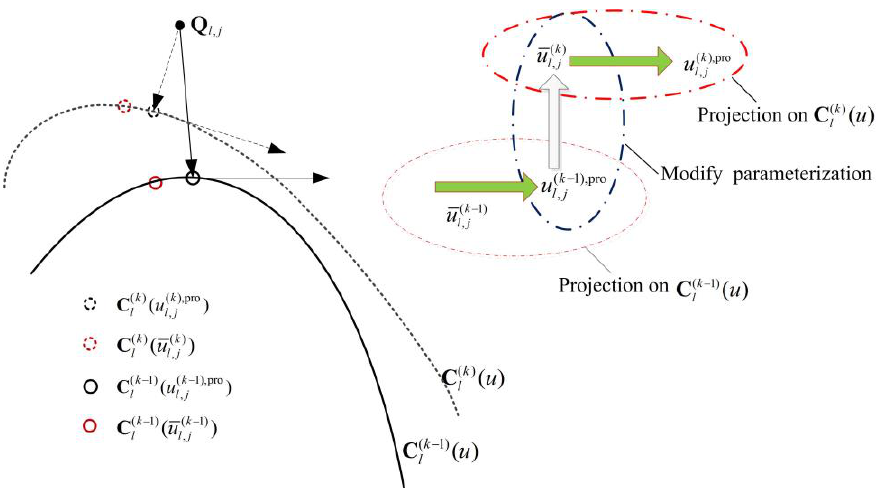
Figure 4. The process of iterative projection optimization during curve fitting.